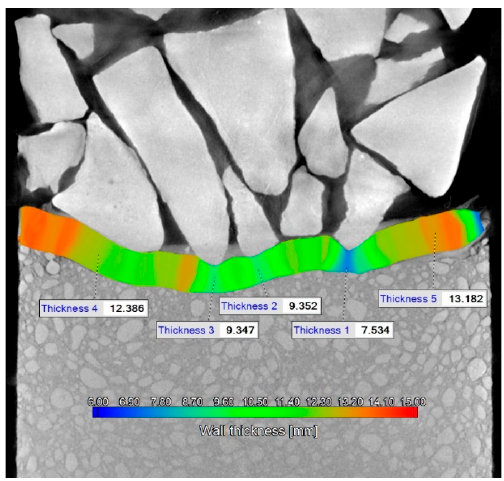
Figure 9. Thickness measurement of CC. Figure 10. Thickness measurement of